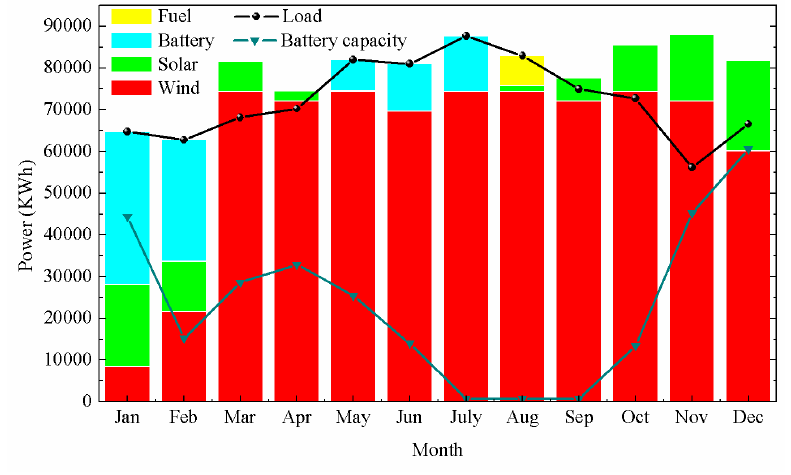
Figure 16. The power generation of the standalone renewable energy system in Zhongshan Station from 2014 to 2015.